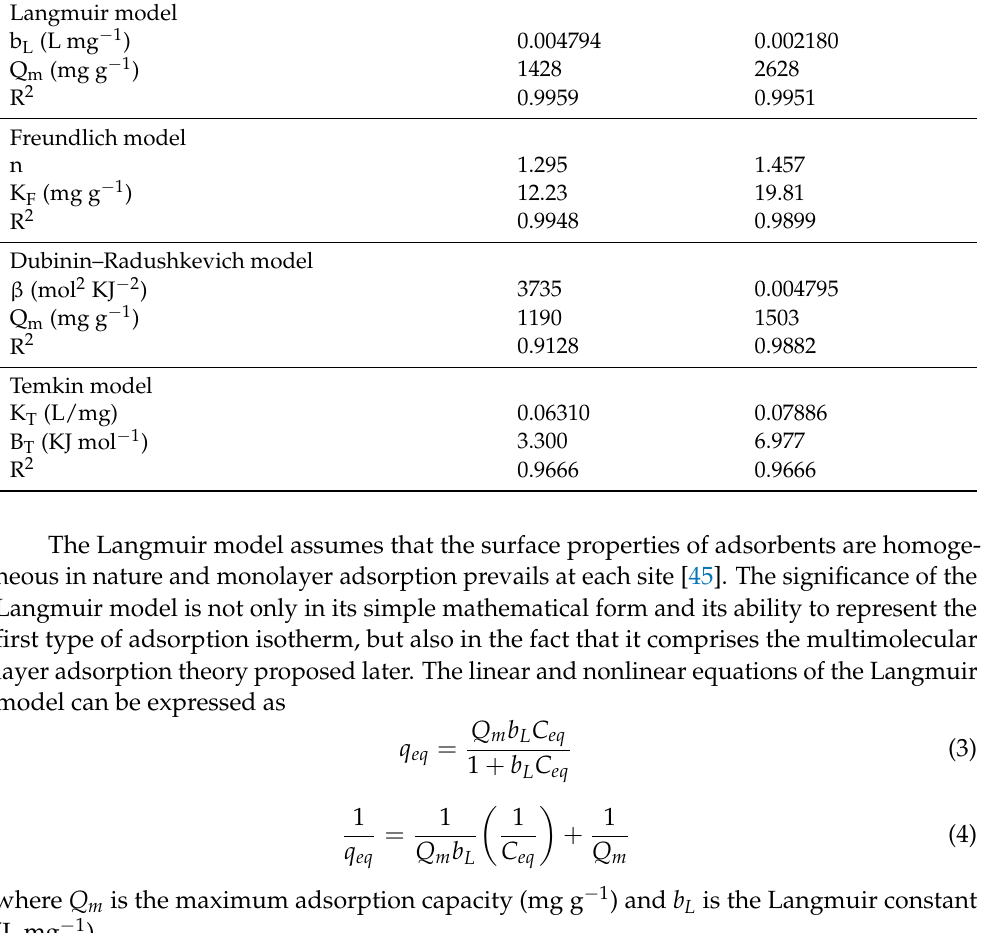
Table 2. Isotherm parameters of PrK adsorption by Co 4 PW–PDDVAC composite. Parameters Linear